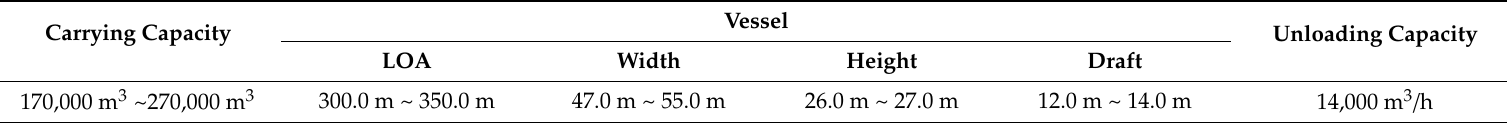
Table A17. Berth Facility for